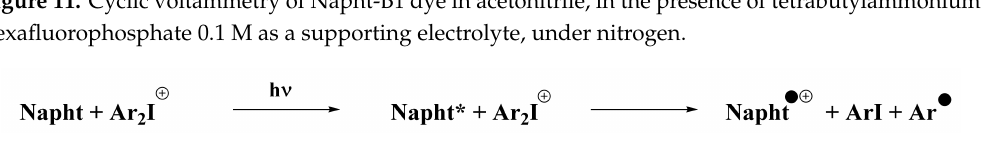
Scheme 7. Redox reaction predicted between the iodonium salt and the naphthalimide derivative.